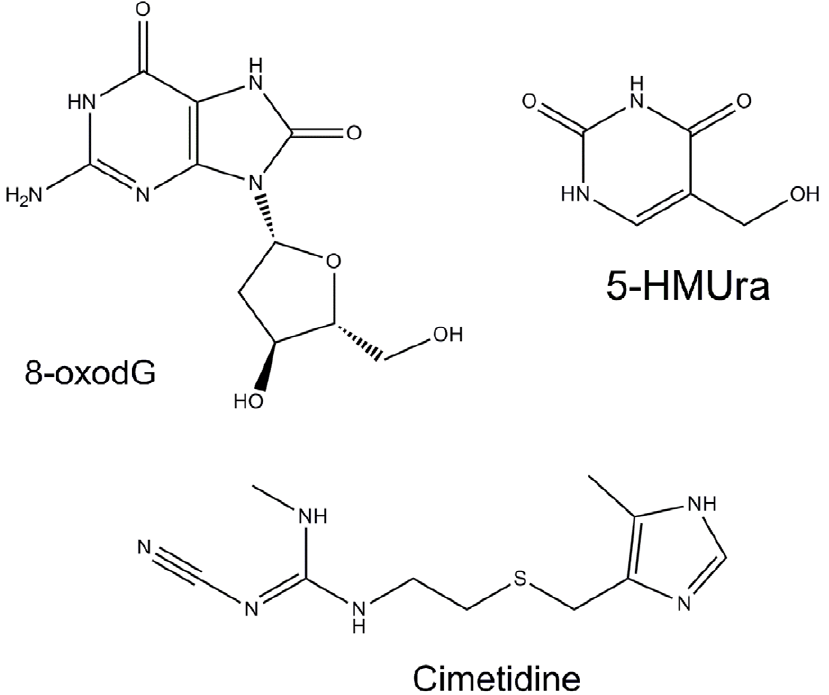
Figure 1. Chemical structures of 8-hydroxy-2 9 -deoxyguanosine (8-oxodG), 5-hydroxymethyluracil (5-HMUra) and cimetidine (used as internal standard - IS).